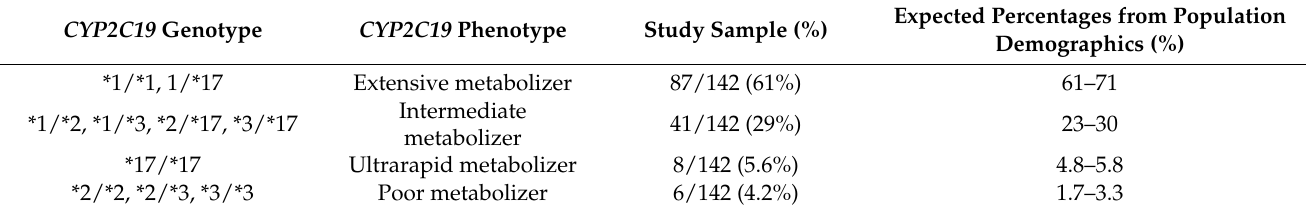
Table 2. Results of CYP2C19 POC